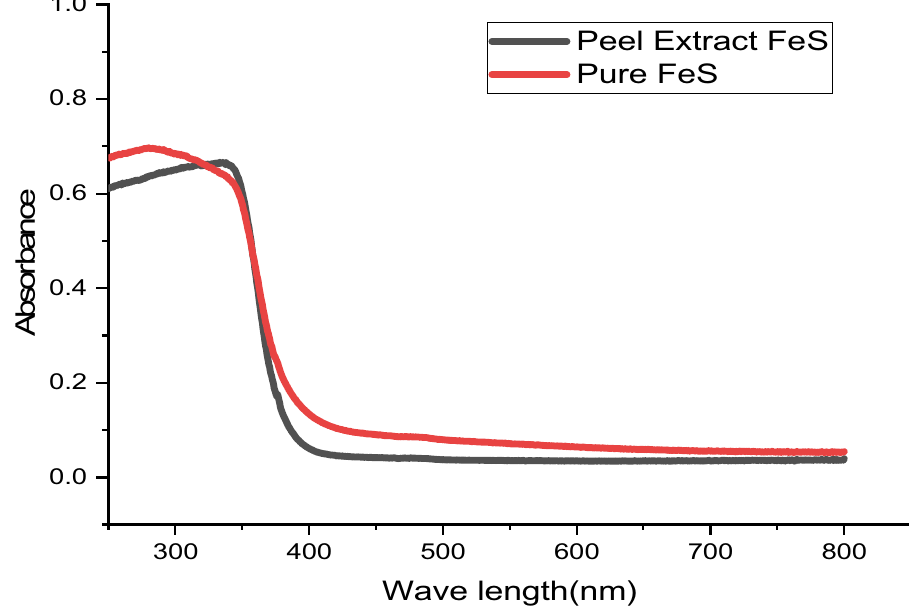
Figure 5. The absorbance of iron sulphide thin films deposited as nanocrystalline FeS from banana leaf extraction and pure FeS thin films.